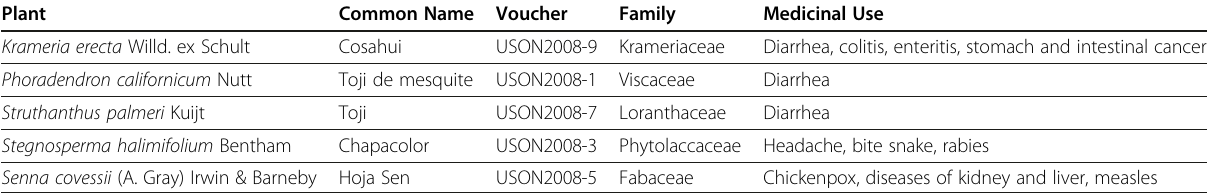
Table 1 List of plants of the ethnopharmacopeia from Northwestern Mexico screened for the in vitro antiproliferative and antioxidant activities